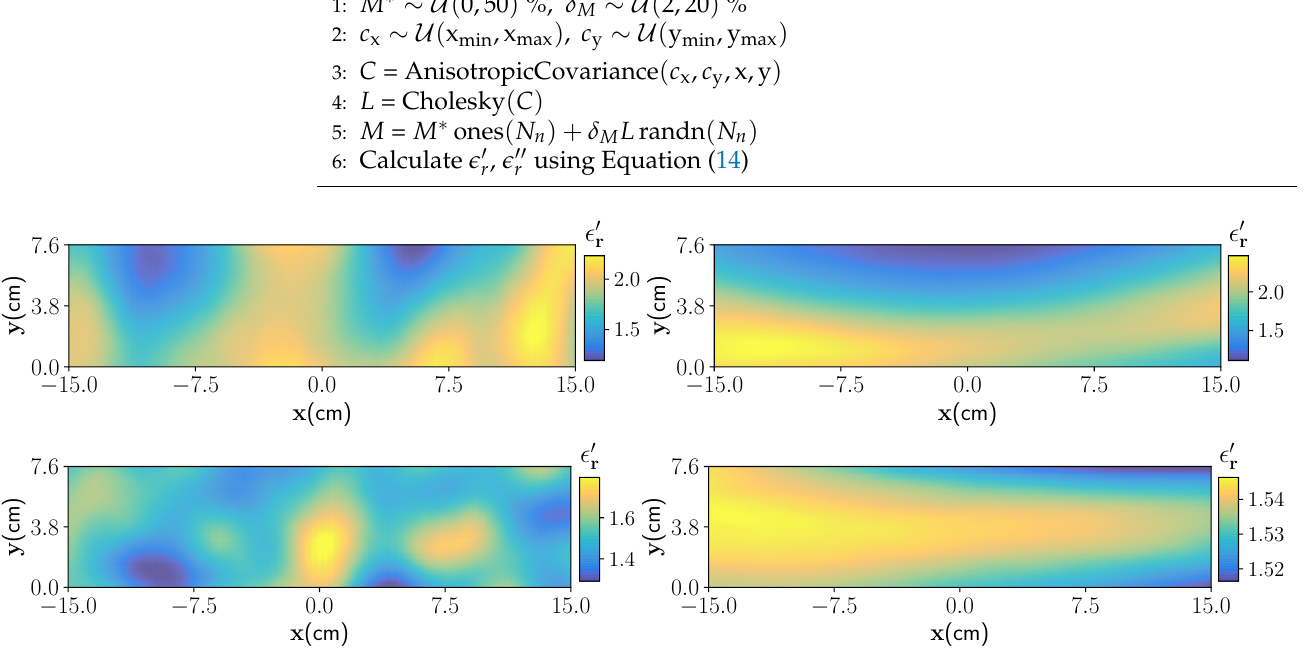
Figure 3. Four realisation of the moisture distribution with different correlation lengths, and mean and standard deviation parameters. In the top right figure the characteristic parameter are l x = 3cm and l y = 7cm, and for the top left figure characteristic parameter are l x = 18cm and l y = 4cm. Wet-spots ( l x = 3cm, and l y = 3cm) and nearly homogeneous moisture distribution ( l x = 30cm, l y = 7cm, and δ M = 2%) are shown in bottom left and right figures,